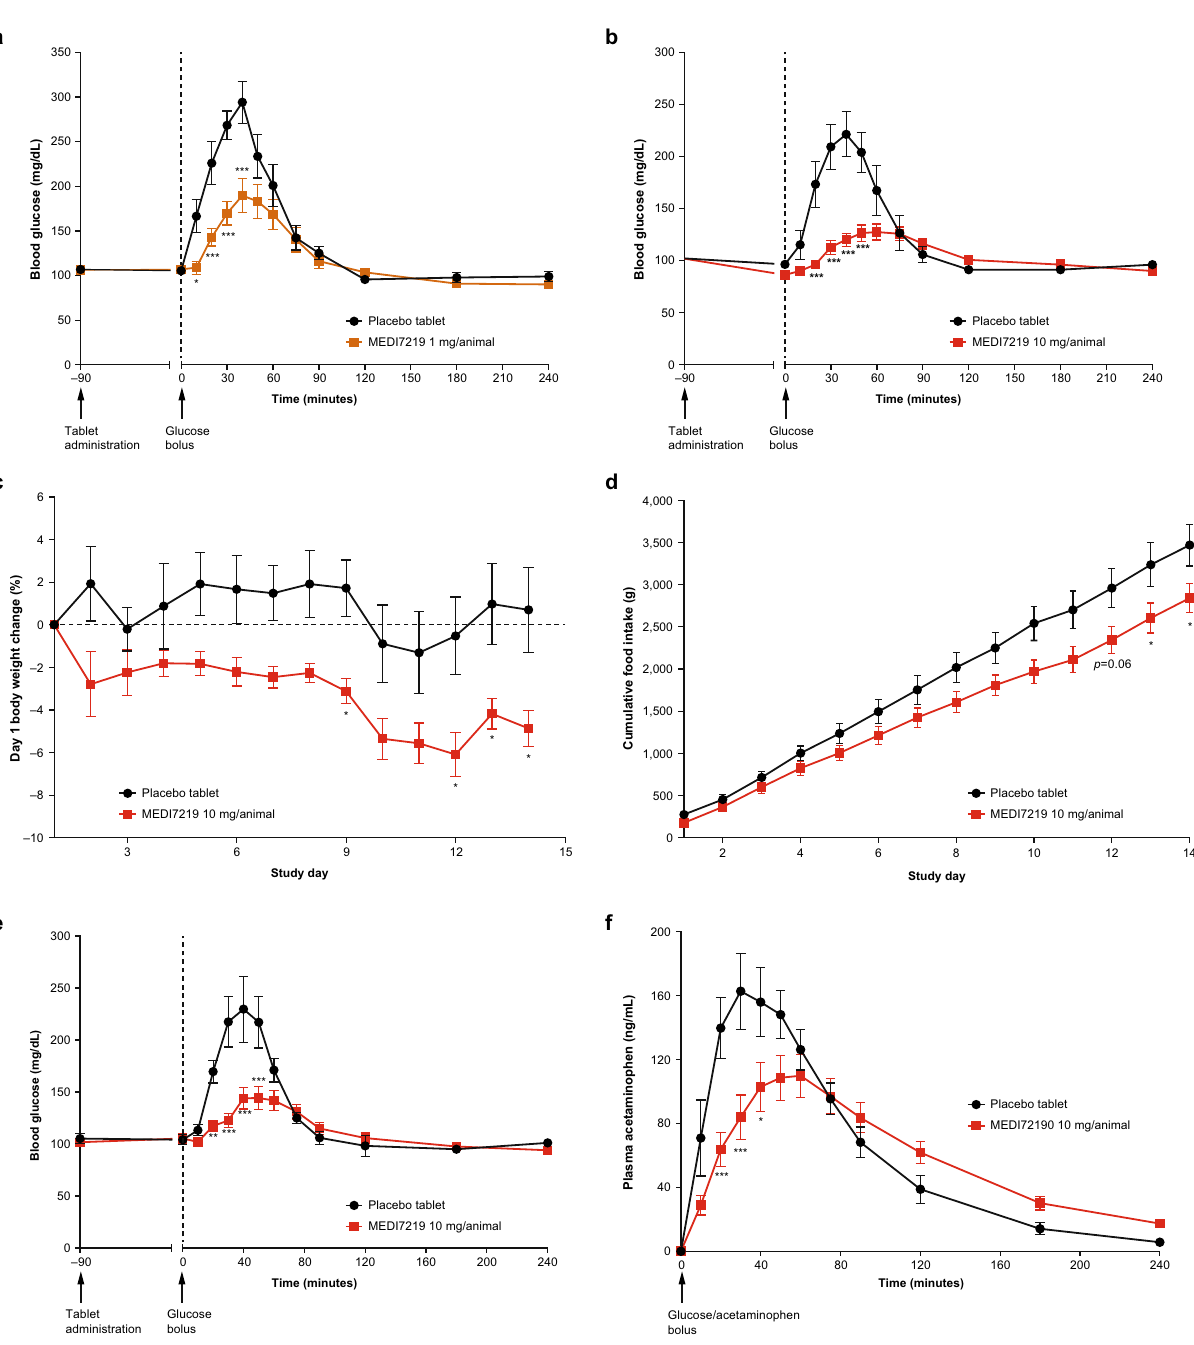
Figure 5. Pharmacodynamic effects of MEDI7219 in HFHF fed dogs. Oral glucose tolerance test in HFHF fed dogs after treatment with a single ( a ) 1 mg/animal or ( b ) 10 mg/animal oral dose of MEDI7219 or placebo tablets (n = 7–11 per group). ( c ) Change in body weight over 14 days in HFHF fed dogs treated with a daily oral dose of MEDI7219 10 mg/animal or placebo tablets. ( d ) Cumulative food intake over 14 days of HFHF fed dogs treated with a daily oral dose of MEDI7219 10 mg/animal or placebo tablets. ( e ) Day 14 oral glucose tolerance test in HFHF fed dogs treated with a daily oral dose of MEDI7219 10 mg/animal or placebo tablets. ( f ) Effect of MEDI7219 on gastric emptying at day 14 in HFHF fed dogs treated with a daily oral dose of MEDI7219 10 mg/ animal or placebo, as shown by plasma acetaminophen levels monitored after administration of acetaminophen with glucose bolus during glucose tolerance testing. * P < 0.05, ** P < 0.01, *** P < 0.001 versus placebo in all panels. Values are mean ± standard error of mean (MEDI7219, n = 12 per group; placebo, n = 6 per group in the multiple-dose